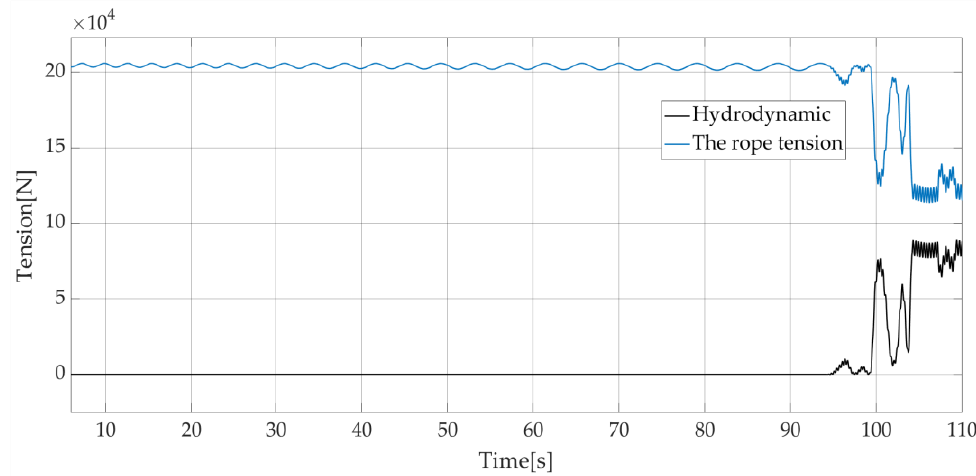
Figure 17. L = 5 m, V = 0.2 m/s rope tension and hydrodynamic forces on the load without wave synchronization.